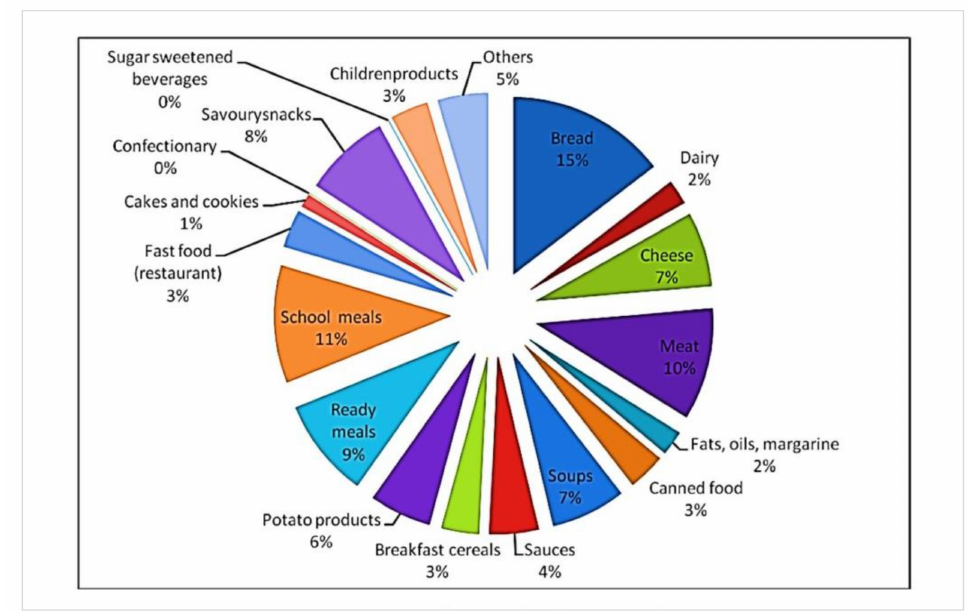
Figure 3. Food commodities on which reformulations aimed at salt content reduction are focused [14].